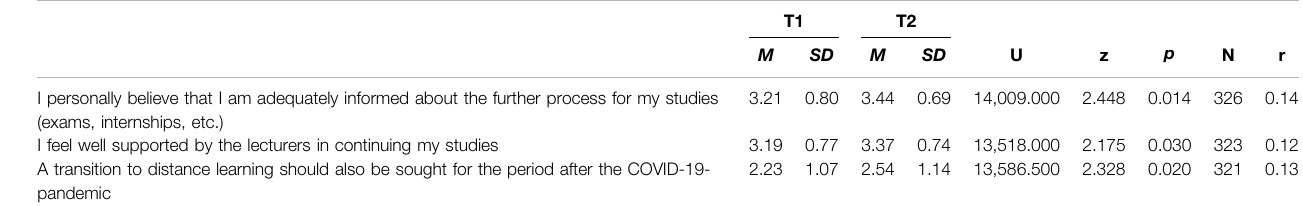
TABLE 3 | Students ’’ perceptions of support, over time.